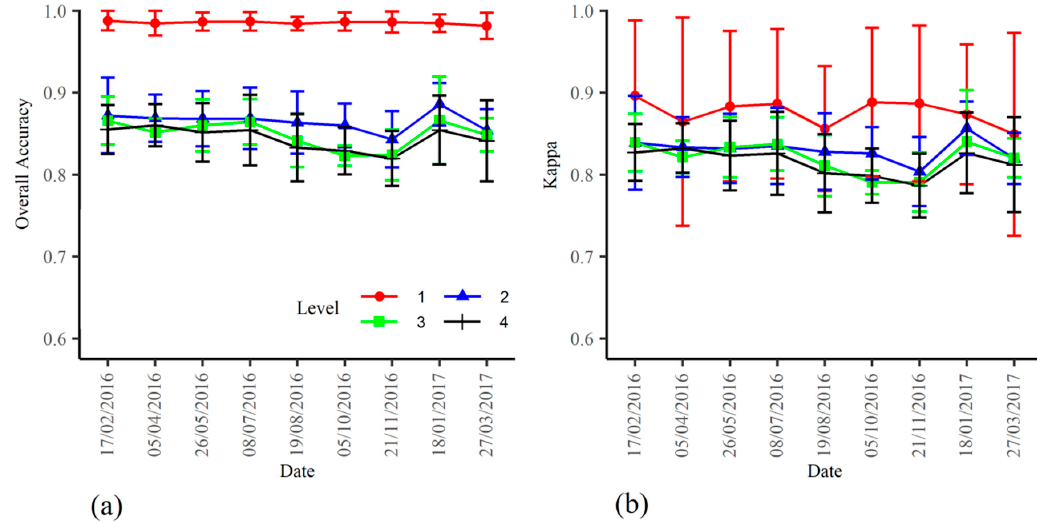
Figure 8. Corrected OA and kappa statistics computed at each classified date and for different levels (correction of OA following [82]).